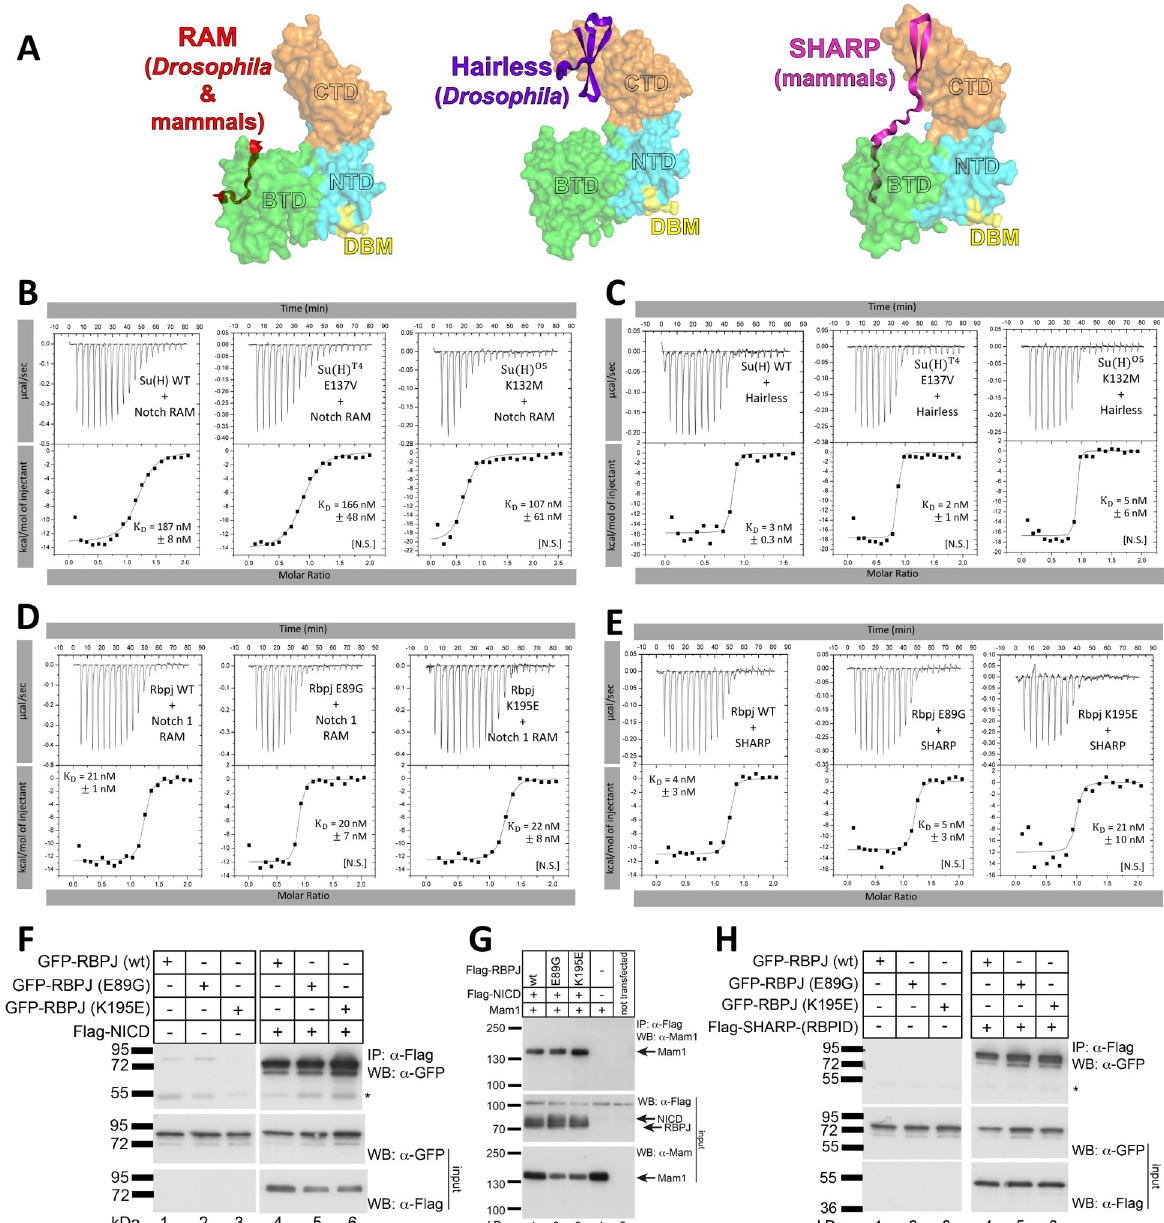
Fig 6. The Su(H)/RBPJ variants bind the co-activator and co-repressor proteins as well as WT Su(H)/RBPJ. A. Structures of the RAM domain (left, PDBID: 3V79) [51], Hairless (middle, PDBID: 5E24) [29], and SHARP (right, PDBID: 6DKS) [31] bound to Su(H)/RBPJ, with DNA removed from the model for simplicity. Su(H)/RBPJ is represented as a surface colored by domains as in Fig 1C, with the Su(H) and RBPJ DNA binding variants of the NTD colored yellow and labeled DBM (DNA Binding Mutation). The cofactors are represented as solid cartoons with RAM in red, Hairless in purple, and SHARP in pink. B-E. Representative thermograms showing the raw heat signal and nonlinear least squares fit to the integrated data from ITC experiments with (B) Drosophila Notch RAM in the syringe and Su(H) in the cell, (C) Drosophila Hairless in the syringe and Su(H) in the cell, (D) mouse Notch 1 RAM in the syringe and mouse Rbpj in the cell, and (E) mouse SHARP in the syringe and mouse Rbpj in the cell. Each ITC experiment was performed at 25˚C with 20 injections. The average dissociation constants (K D ) and standard deviations from triplicate experiments are reported along with the p-value determined from a two-tailed T-test ([ ��� ] P < 0.001, [ �� ] P < 0.01, [ � ] P < 0.05 and [NS] not significant). For the RAM binding experiments: WT Su(H) vs. Su(H) K132M P = 0.142. WT Su(H) vs. E137V P = 0.583. WT RBPJ vs. E89G P = 0.860. WT RBPJ vs. K195E P = 0.789. For the Hairless/SHARP binding experiments: WT Su(H) vs. Su(H) K132M P = 0.605. WT Su(H) vs. E137V P = 0.185. WT RBPJ vs. E89G P = 0.614. WT RBPJ vs. K195E P = 0.079. F. NICD binding of WT and variant mouse Rbpj proteins from cells. HEK293 cells were transfected with the plasmids GFP-Rbpj WT, GFP-Rbpj E89G, or GFP-Rbpj K195E in the absence or presence of Flag- NICD. Immunoprecipitation was performed with anti-Flag antibody agarose beads and detected by Western blotting using an anti-GFP antibody.